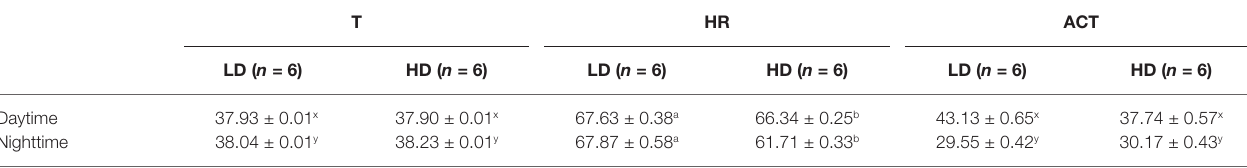
TABLE 2 | Mean (±SEM) daytime (07:00–21:00 h) and nighttime (22:00–06:00 h) temperature (T, ° C), heart rate (HR, bpm), and activity (ACT, mg) of six cows that were maintained at 1.5 LSUs/ha (LD) and were moved to a grazing area that had a density of 128 LSUs/ha (HD). T